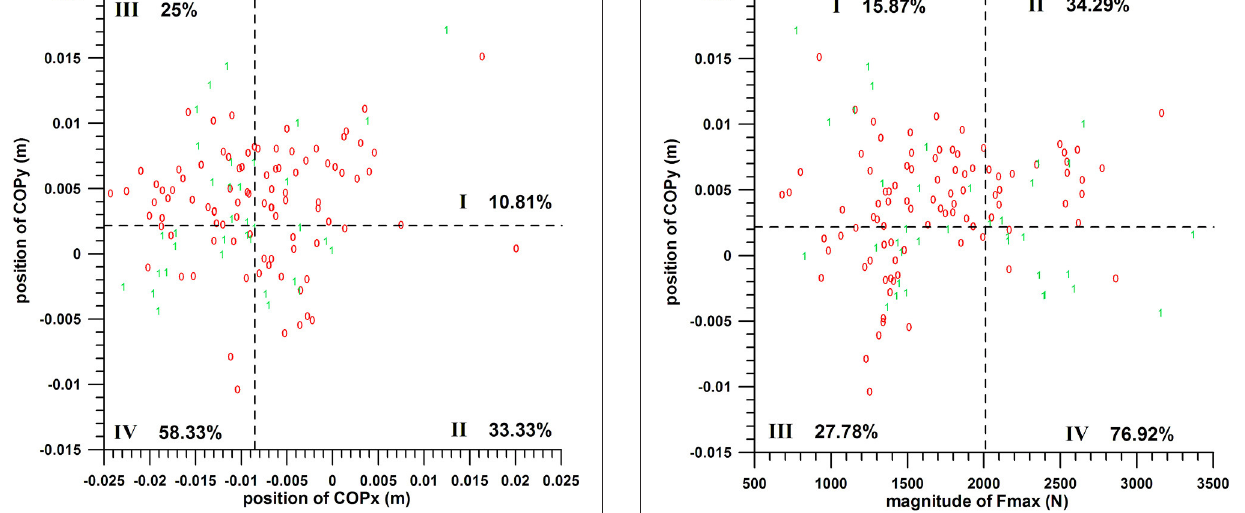
FIGURE 9 | Two-parameter analysis: COPy vs. Fmax (peak impact force); 0 = miss, 1 = hit; dashed lines = threshold values (cf. Table 1 ); I, II, III, IV = group codes from Table 2 .